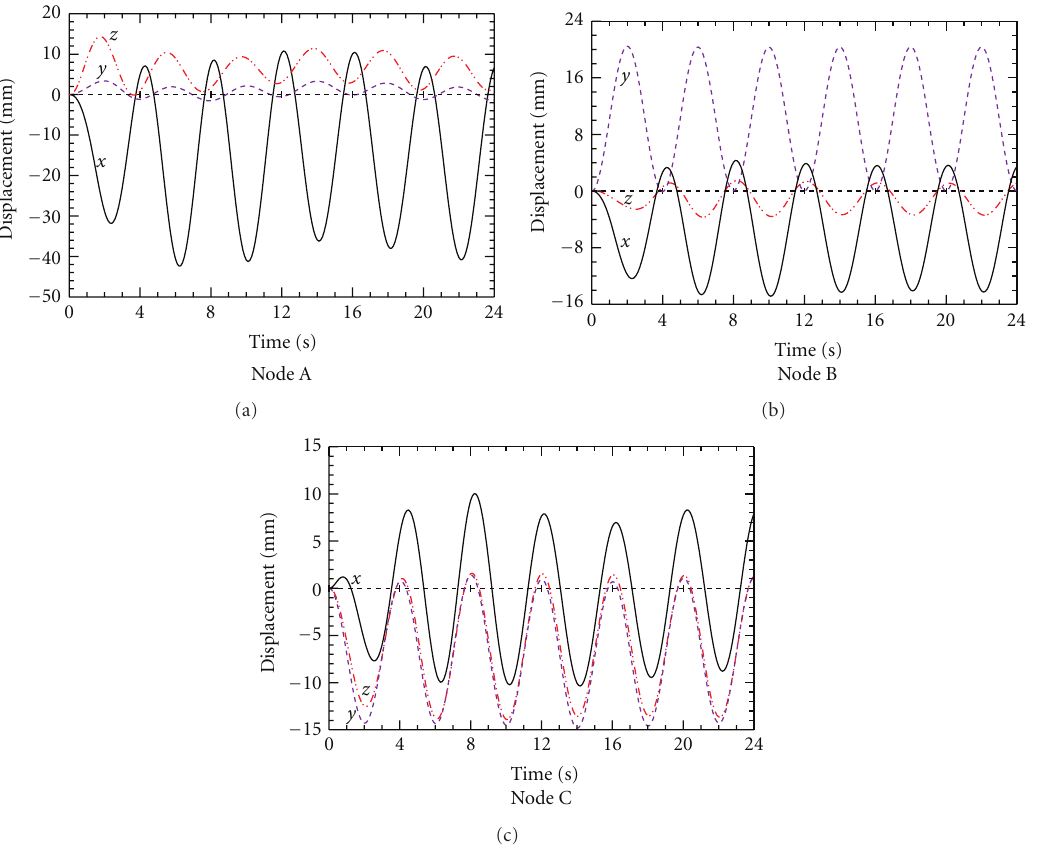
Figure 11: Predicted displacement for nodes A, B, and C over 6 breathing cycles with anisotropic YM